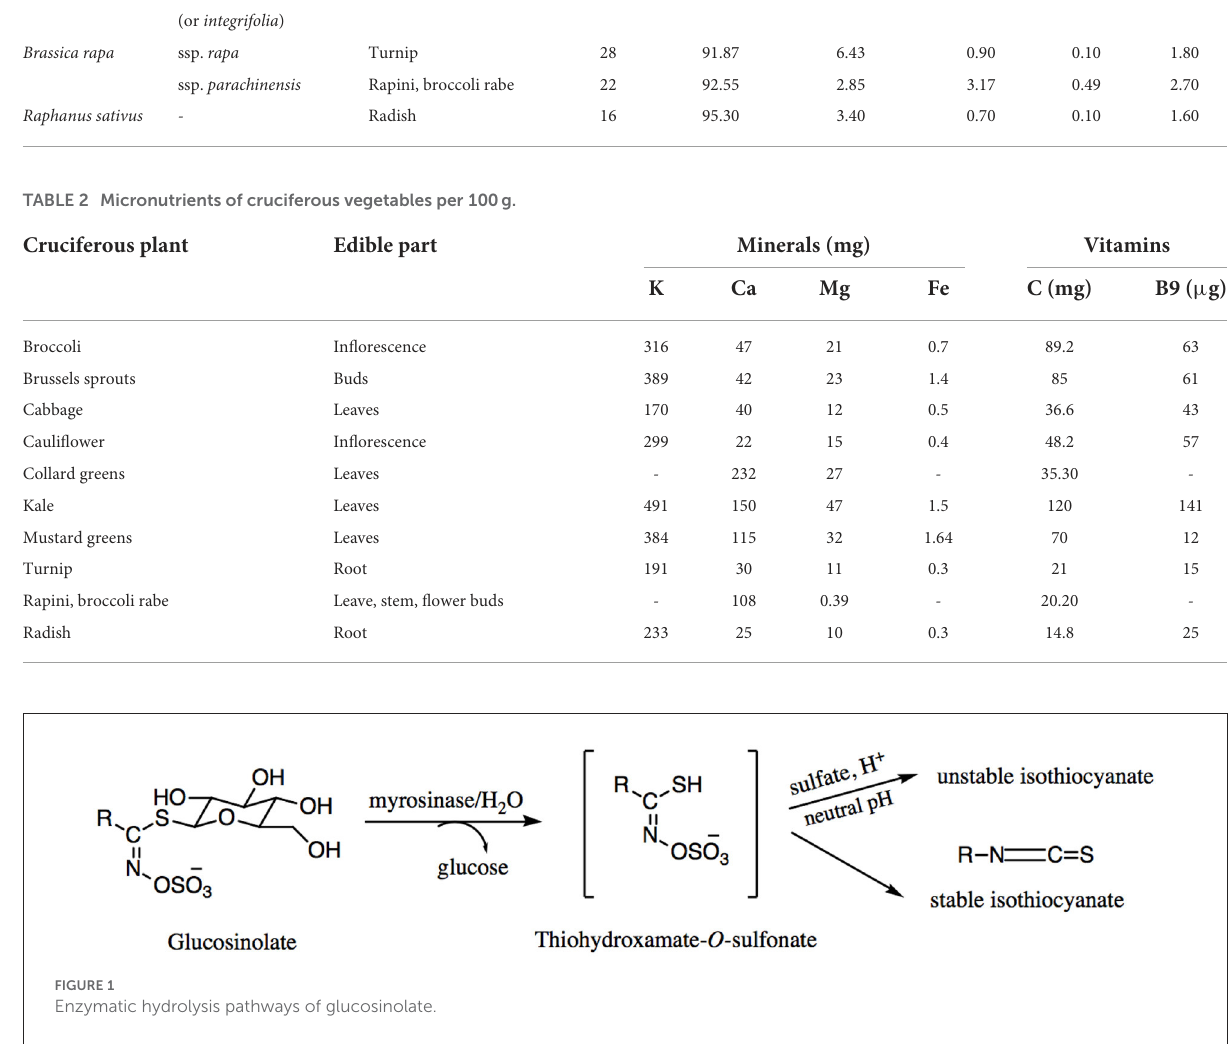
(Figure 3) and β -carotene as the predominant ones, followed by α -carotene, γ -carotene, β -cryptoxanthin, and lycopene presenting an antioxidant activity (39). Other carotenoids such as zeaxanthin, cryptoxanthin, neoxanthin, and